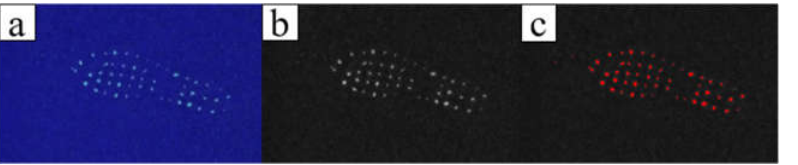
Figure 3. Image processing: ( a ) original fluorescence image, ( b ) gray fluorescence image, and ( c ) threshold range for the selected region.